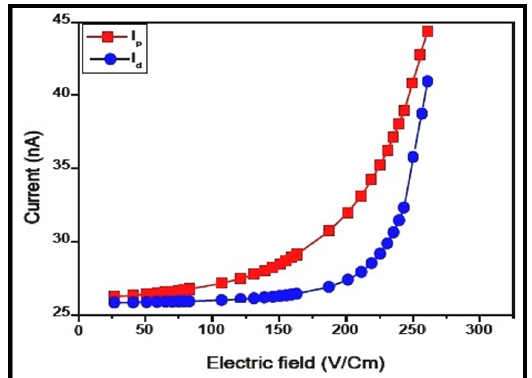
Fig.9. Photoconductivity study of TiO